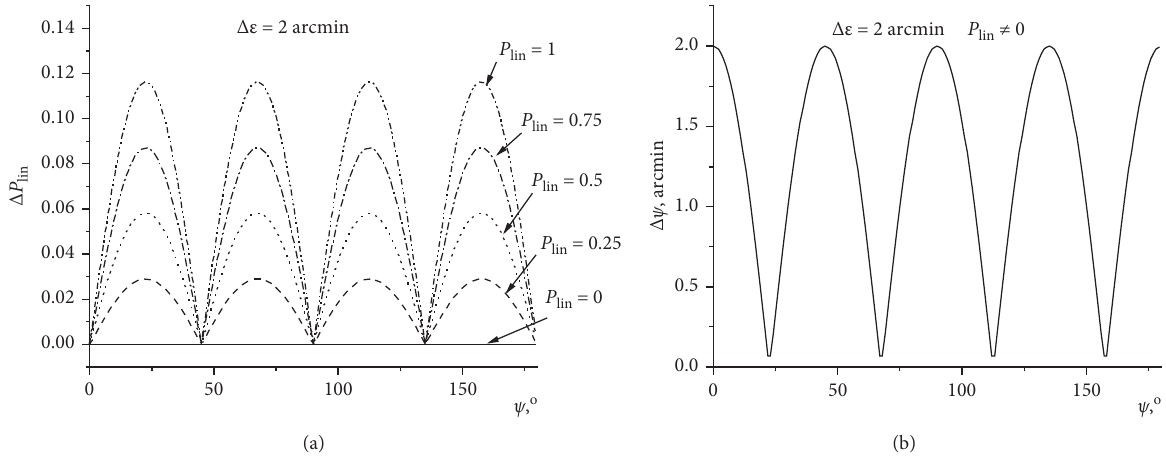
Figure 12: Dependence of the errors Δ P and azimuth Δ ψ of linear polarization of the light on the azimuth of polarization ψ at different lin , polarization, with the error Δ ε � 2 arcmin of mount azimuths of the Wollaston prisms. values of the degree of P lin